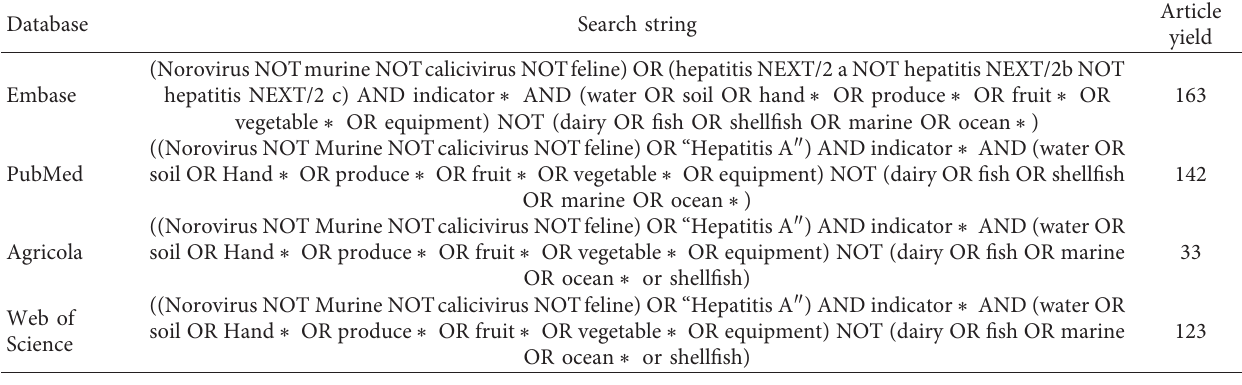
Table 1: Search string operations.